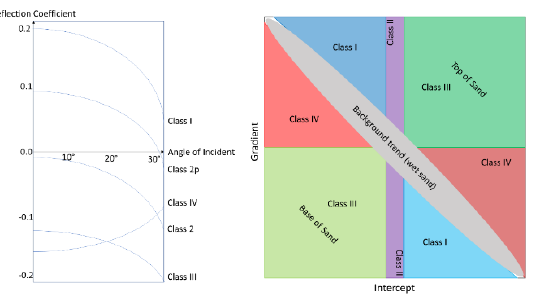
Figure 1. AVO classification by identifying the gradient of change in seismic reflection with various angles of incident.